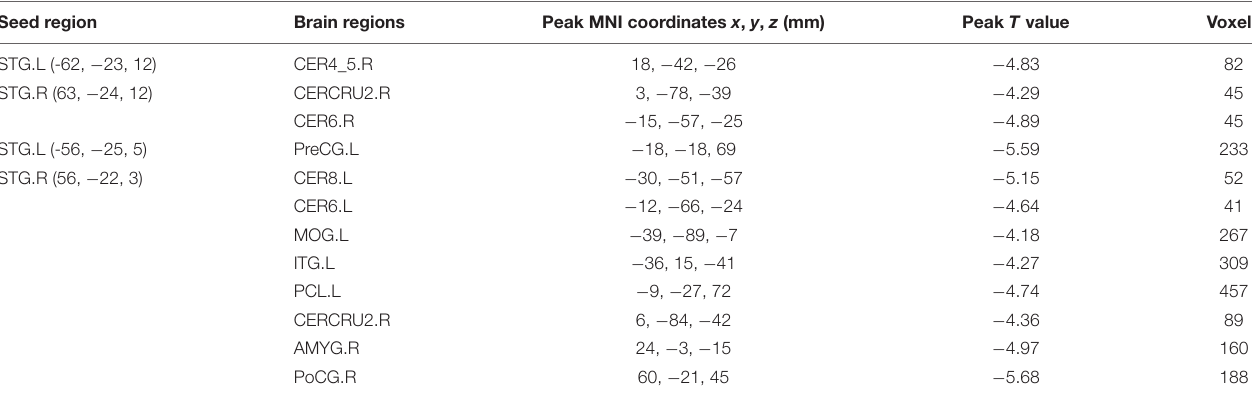
TABLE 3 | Regions showing significant differences of auditory-FC between ISSNHL patients and healthy